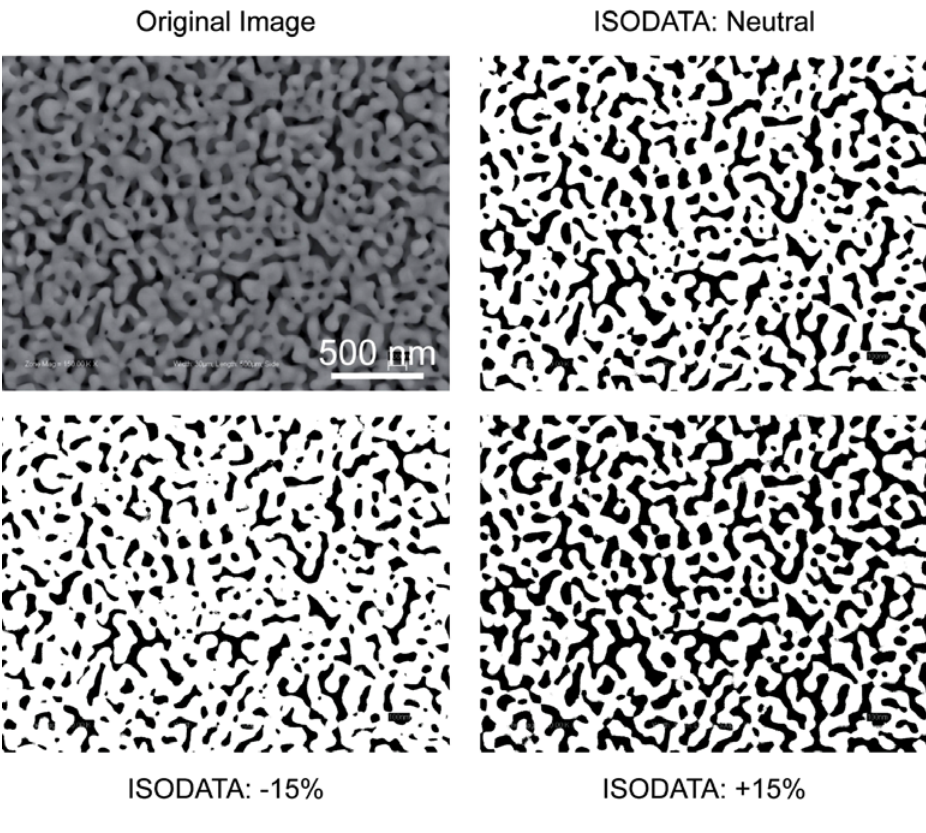
Figure 13. The percent coverage of pores (dark regions), as well as calculated values, depend on the thresholding level selected. For the example image above, the calculated percent porosity and average pore size values were 30% and 80 nm for the “neutral” case; 23% and 65 nm for the “ − 15%” case; and 39% and 110 nm for the “+15%”